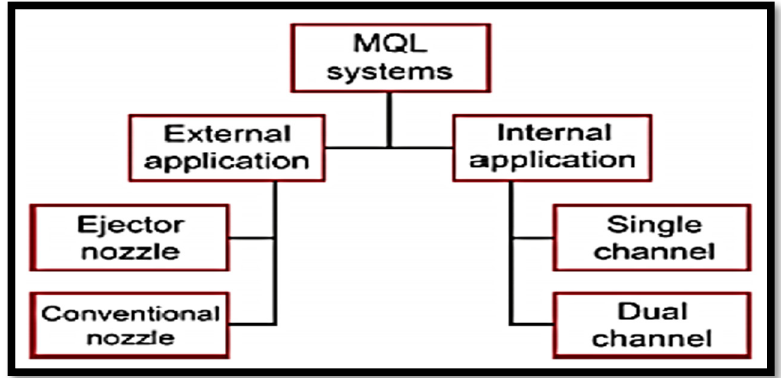
Figure 12. Minimum quantity lubrication delivery system categorizations [95].